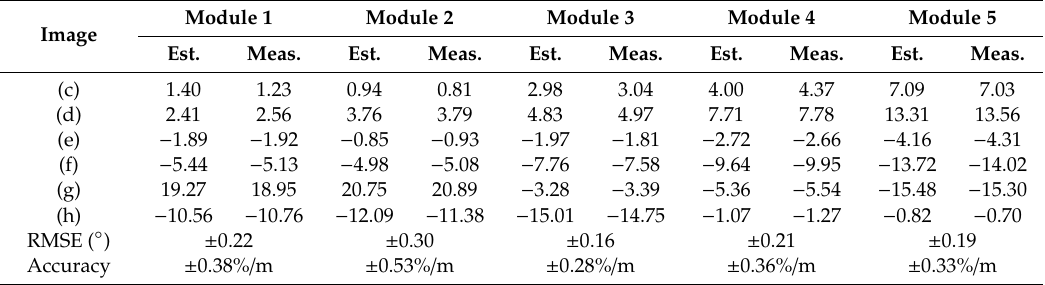
Table 3. Inclination data measured by each module in different geometric configurations of the inclinometer chain.